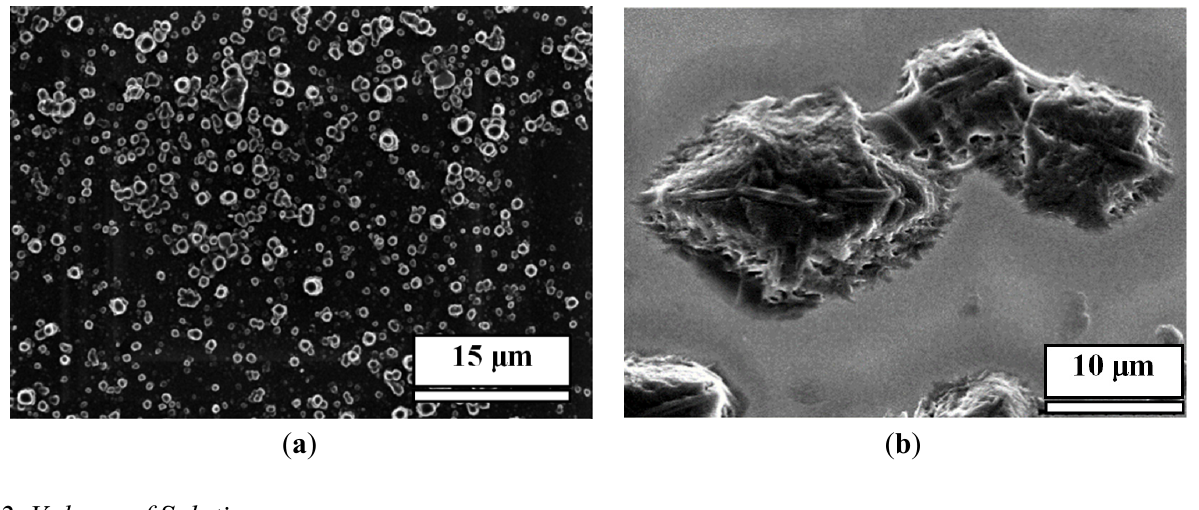
Figure 4. SEM images of CA/M fabricated from 0.001 M CA and 0.001 M melamine on: